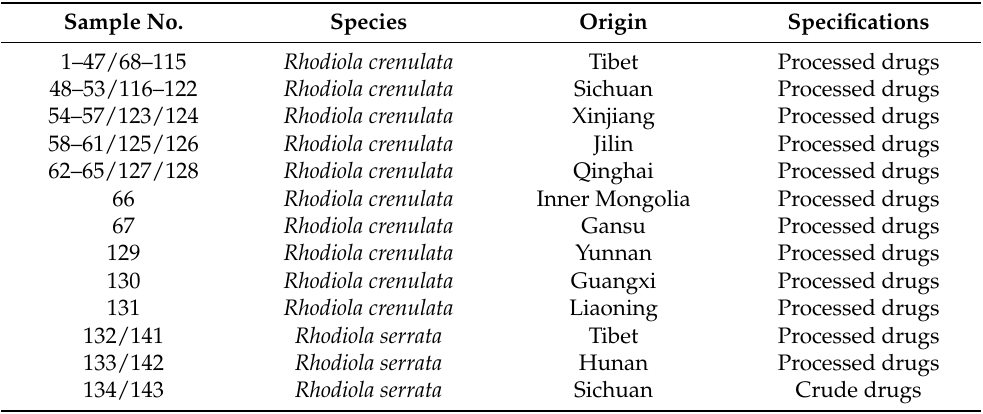
Table 2. The information of Rhodiola